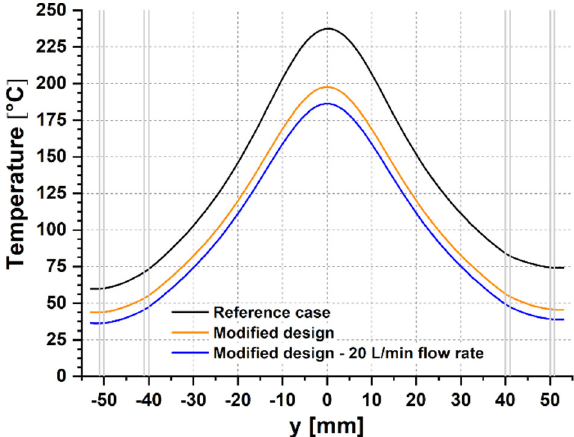
Figure 6. Temperature profiles along the disk diameter at the symmetry plane xy for the conceptual design change with respect to the reference case.